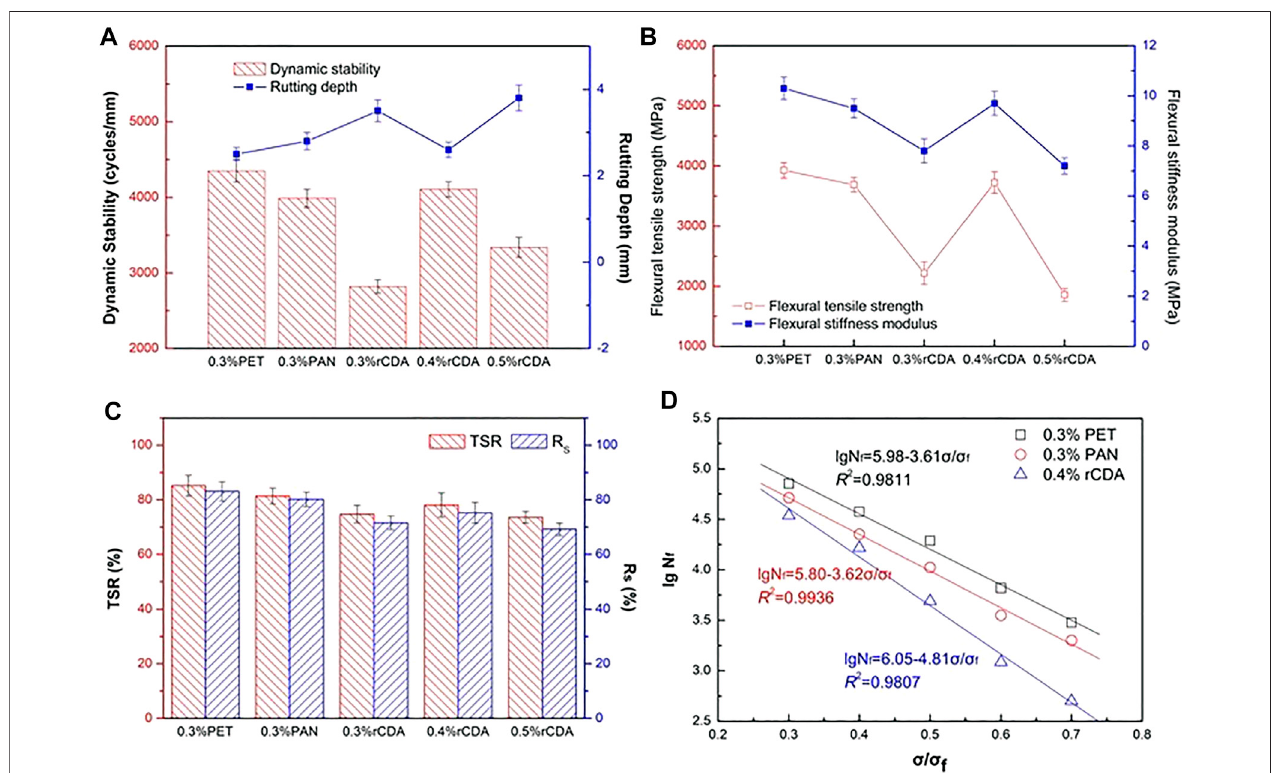
FIGURE5| Experimental resultsforasphaltmixtureswithdifferent fi bers, (A) high-temperaturestability, (B) low-temperatureperformance, (C) moisturesensibility, and (D) fatigue performance.